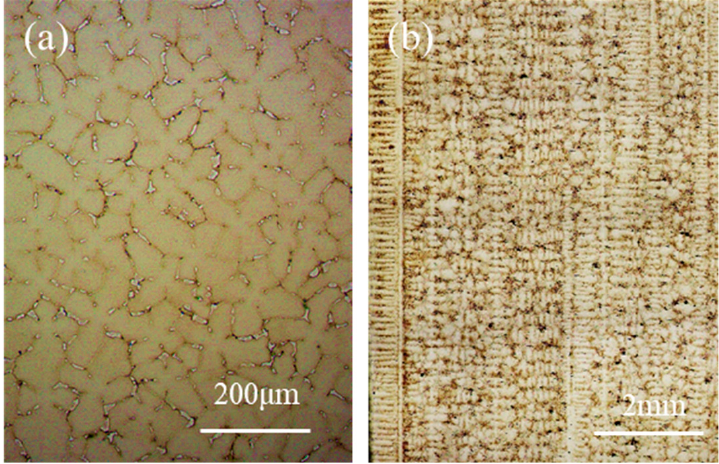
Figure 2. The cross-sectional ( a ) and longitudinal sectional ( b ) microstructure of the directional columnar grains.